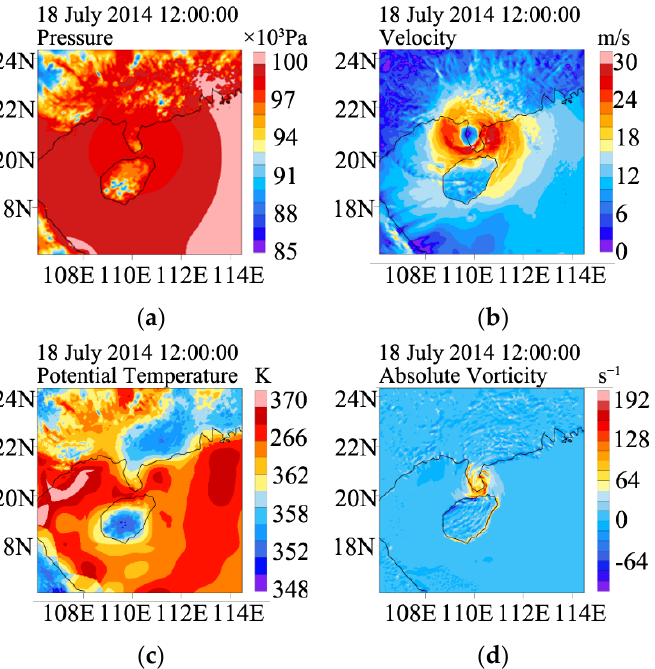
Figure 5. Simulation results of Typhoon Rammasun by WRF model. ( a ) Sea level pressure. ( b ) Wind speed. ( c ) Equivalent potential temperature. ( d ) Absolute vorticity.